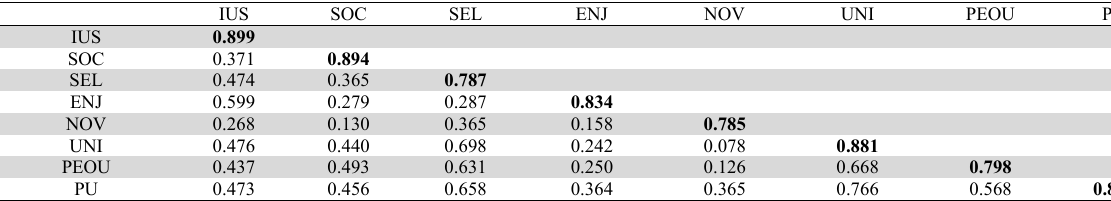
Fornell-Larcker Scale